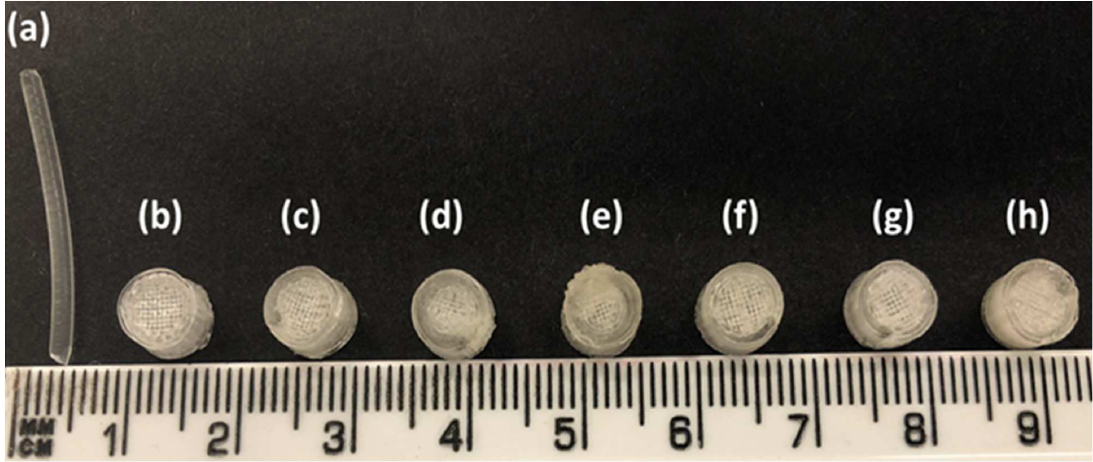
Figure 1. ( a ) Hot-melt extruded filament of gabapentin/polyethylene oxide (PEO); ( b ) F1 (1 shell with 0% infill); ( c ) F2 (2 shells with 0% infill); ( d ) F3 (3 shells with 0% infill); ( e ) F4 (4 shells with 0% infill); ( f ) F5 (2 shells with 10% infill); ( g ) F6 (2 shells with 20% infill); and ( h ) F7 (2 shells with 30% infill).